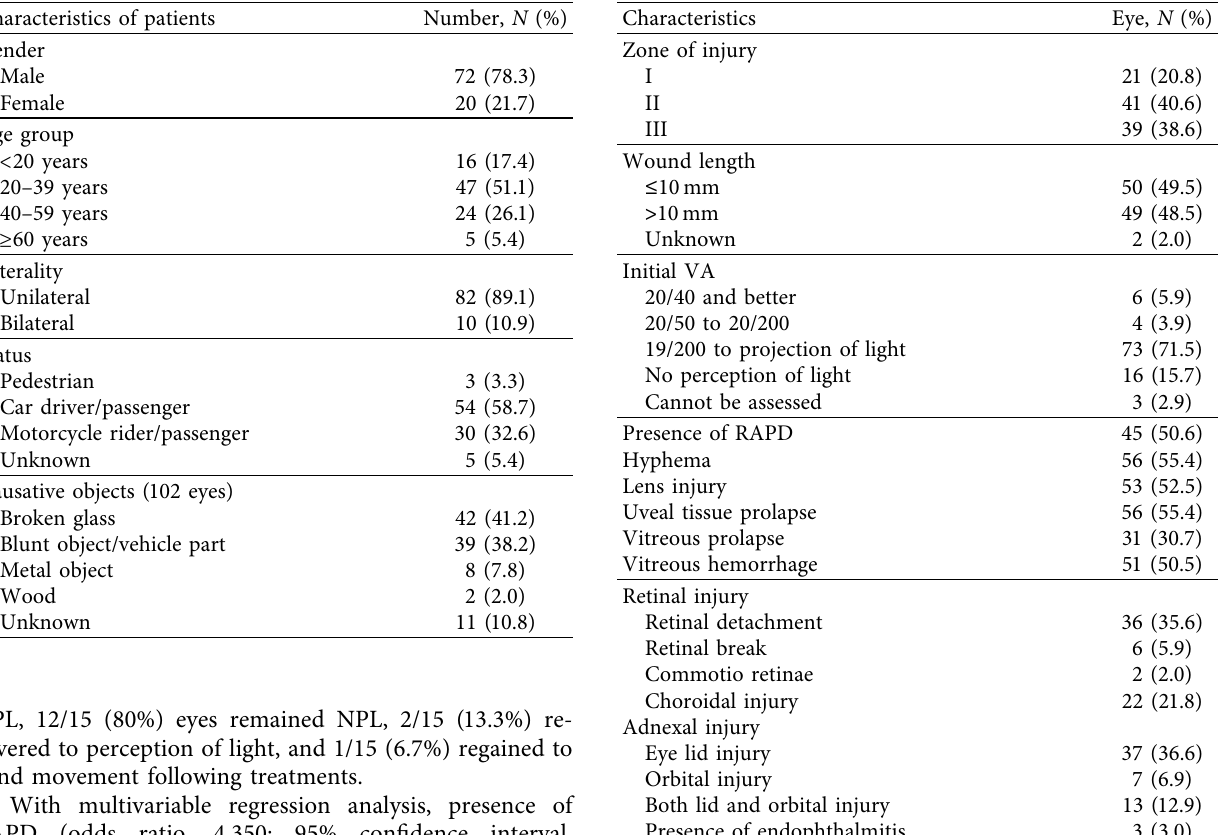
Table 2: Ocular characteristics of road traffic-related open globe injury.